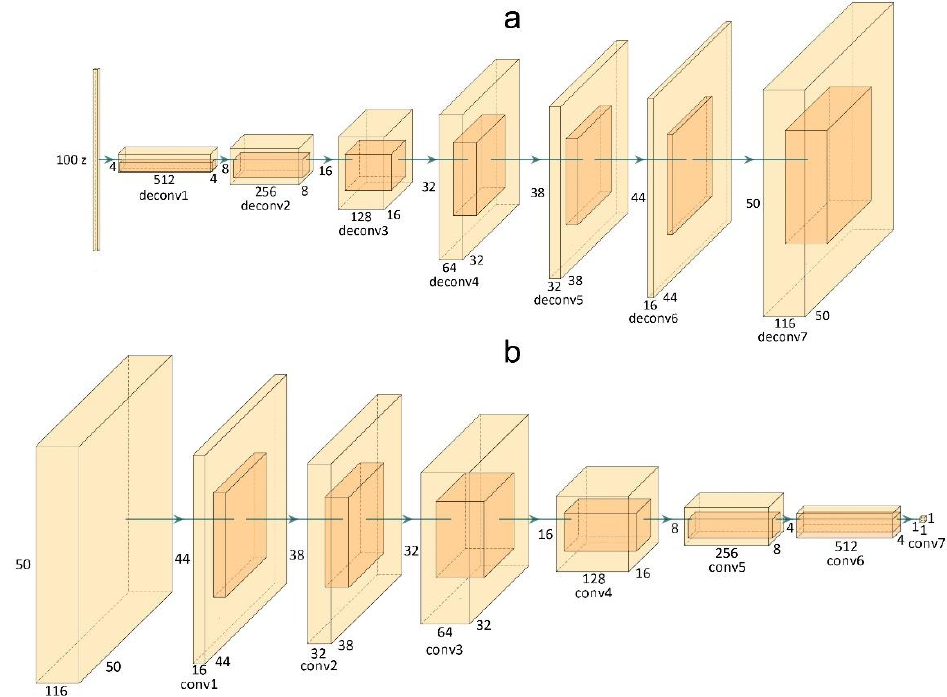
Figure 3. Proposed generator ( a ) and discriminator ( b ) architectures.